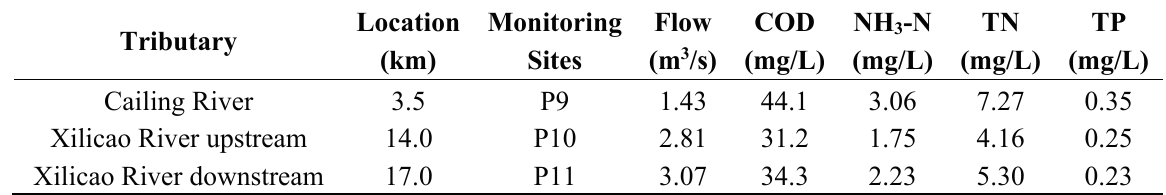
Table 3. The locations and water qualities of main tributaries.